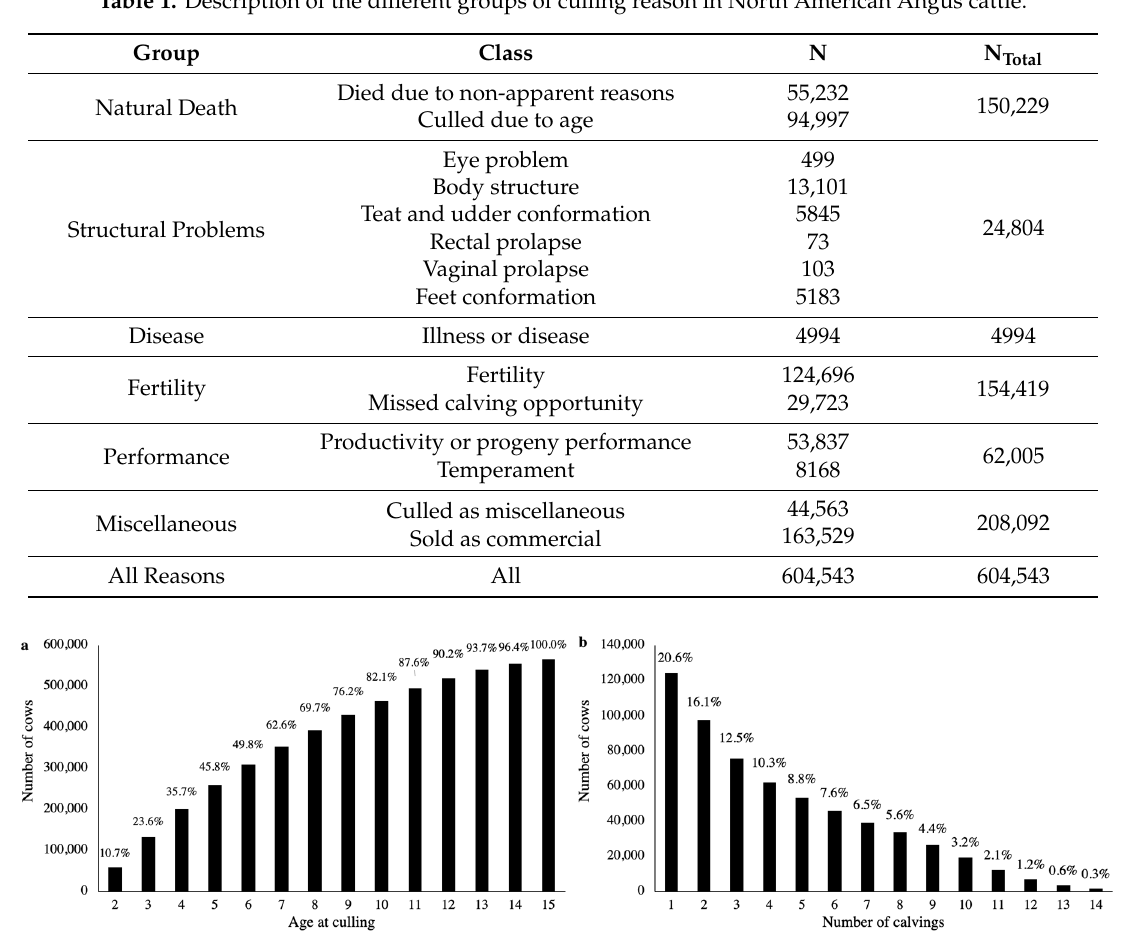
Figure 1. Number of cows by culling age (cumulative; ( a )) and by number of calvings ( b ). Age at culling equal to 15 included cows culled from 15 to 20 years-old.